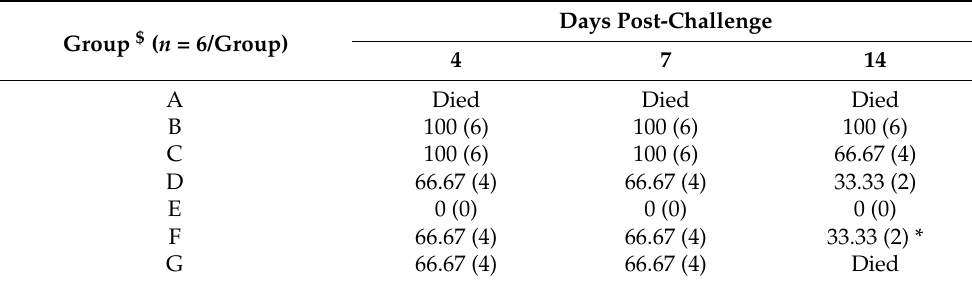
Table 2. Viral shedding from cloacal swabs of experimental SPF chicken following challenge with virulent Newcastle disease